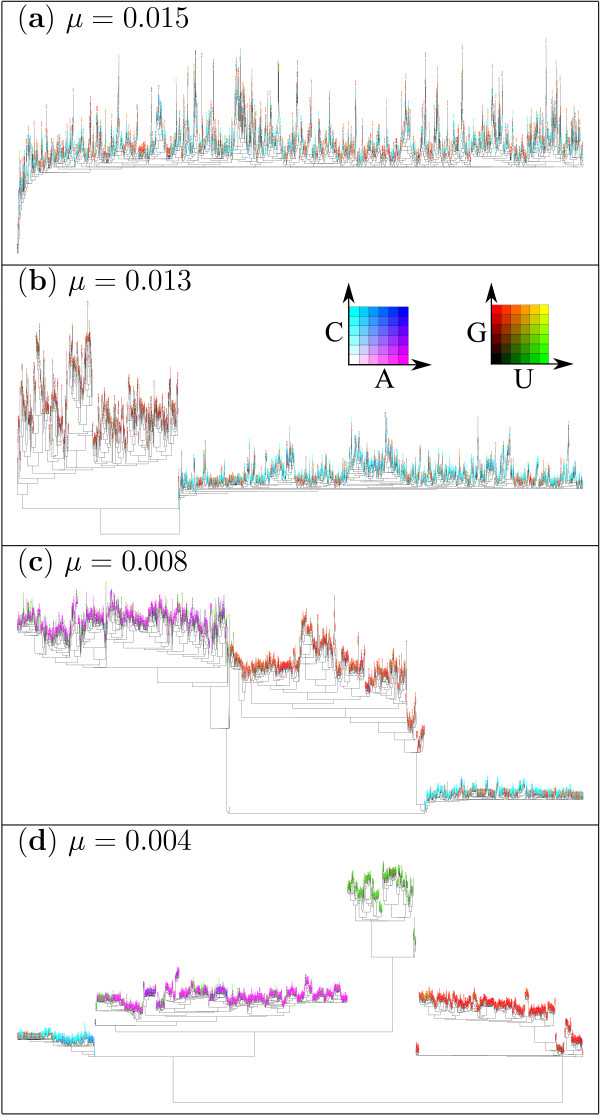
Phylogeny for various mutation rates. Phylogenies are constructed from 2000 genotypes selected from a simulation for various values of the mutation rate (μ). They were constructed through maximum likelihood method by using PHYML [43]. Due to great divergence among sequences and the procedure in genotype selection, the phylogeny depicts only the patterns in the population of sequences, but not necessarily the evolutionary relationship among them (see Methods for details). The leaves of the phylogenies were colored according to the sequence composition of a genotype's dangling-end. For catalytic genotypes, the 5'-dangling-end of the catalytic strand (which is to recognize templates) is chosen. If the dangling-end has more C's, the color becomes more cyan, whereas, if it contains more A's, then the color becomes more magenta. For non-catalytic genotypes, the 3'-dangling-end (which is to be recognized by catalysts) with the most extreme sequence composition among a pair of complementary sequences is chosen. If the dangling-end has more G's, the color becomes more red, whereas, if more U's, then more green. In this coloring scheme, the C-catalyst tends to appear cyan; the A-catalyst, magenta; the G-parasite, red; the U-parasite, green. However, it should be noted that the red leaves appearing in the clades of the C-catalyst are not the G-parasite (e.g., see (a)). Instead, these represent the mutants of the C-catalyst that have lost the catalytic structure, and they are members of the C-catalyst quasi-species (see also "Evolution of the ecological organization" in main text). This is also the case for the green leaves in the clades of the A-catalyst. Finally, for more precise color coding, insets indicate the colors as a function of nucleotide frequencies, where it reads 0.1 on scales (the frequency more than 0.5 are joined). The left (resp. right) inset is for catalytic (resp. non-catalytic) genotypes.